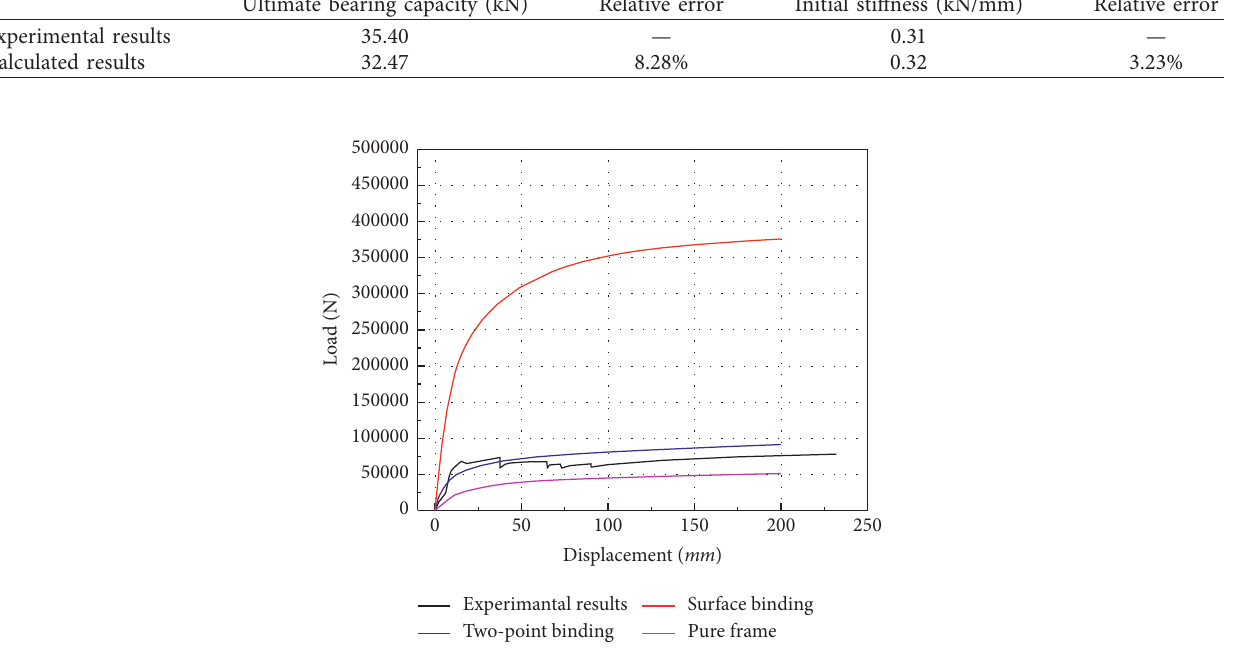
Figure 16: Comparison of load-displacement curve for QX-1. Table 3: Comparison of the ultimate bearing capacity and initial stiffness for